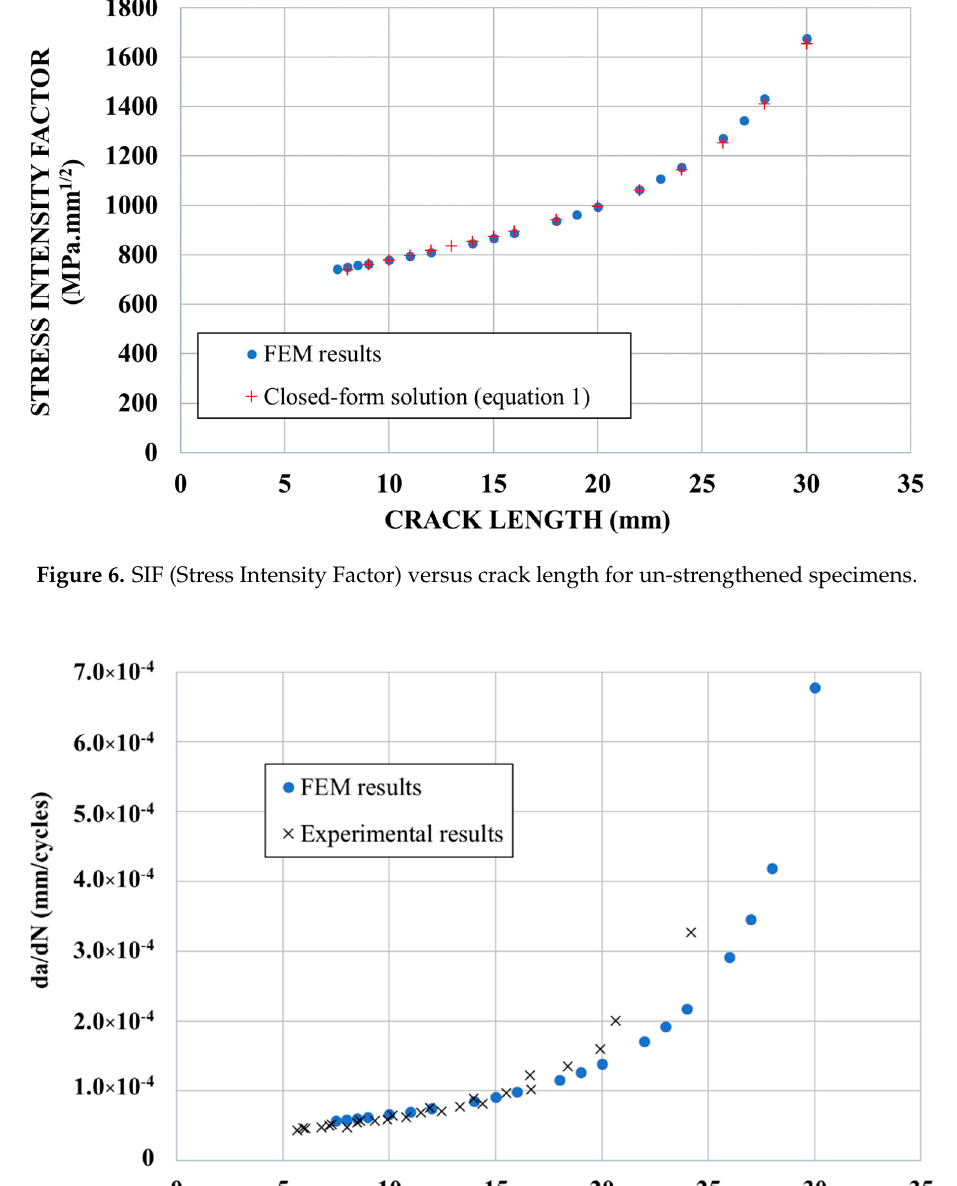
Figure 8. Distribution of SIF along crack front for un-strengthened specimens obtained from FEM (finite element model) results.